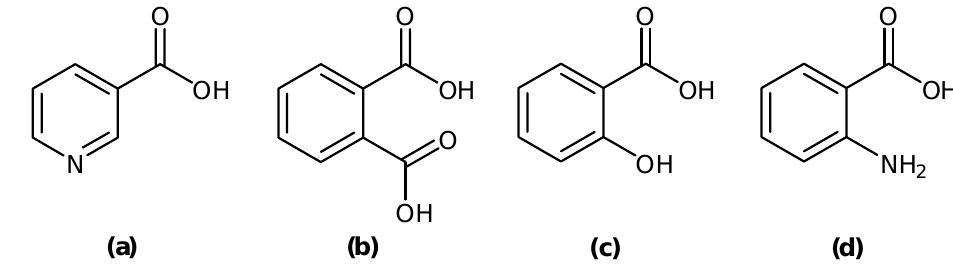
Figure 1. Molecular structure of ligands: nicotinic acid (a), phthalic acid (b), salicylic acid (c), and anthranilic acid